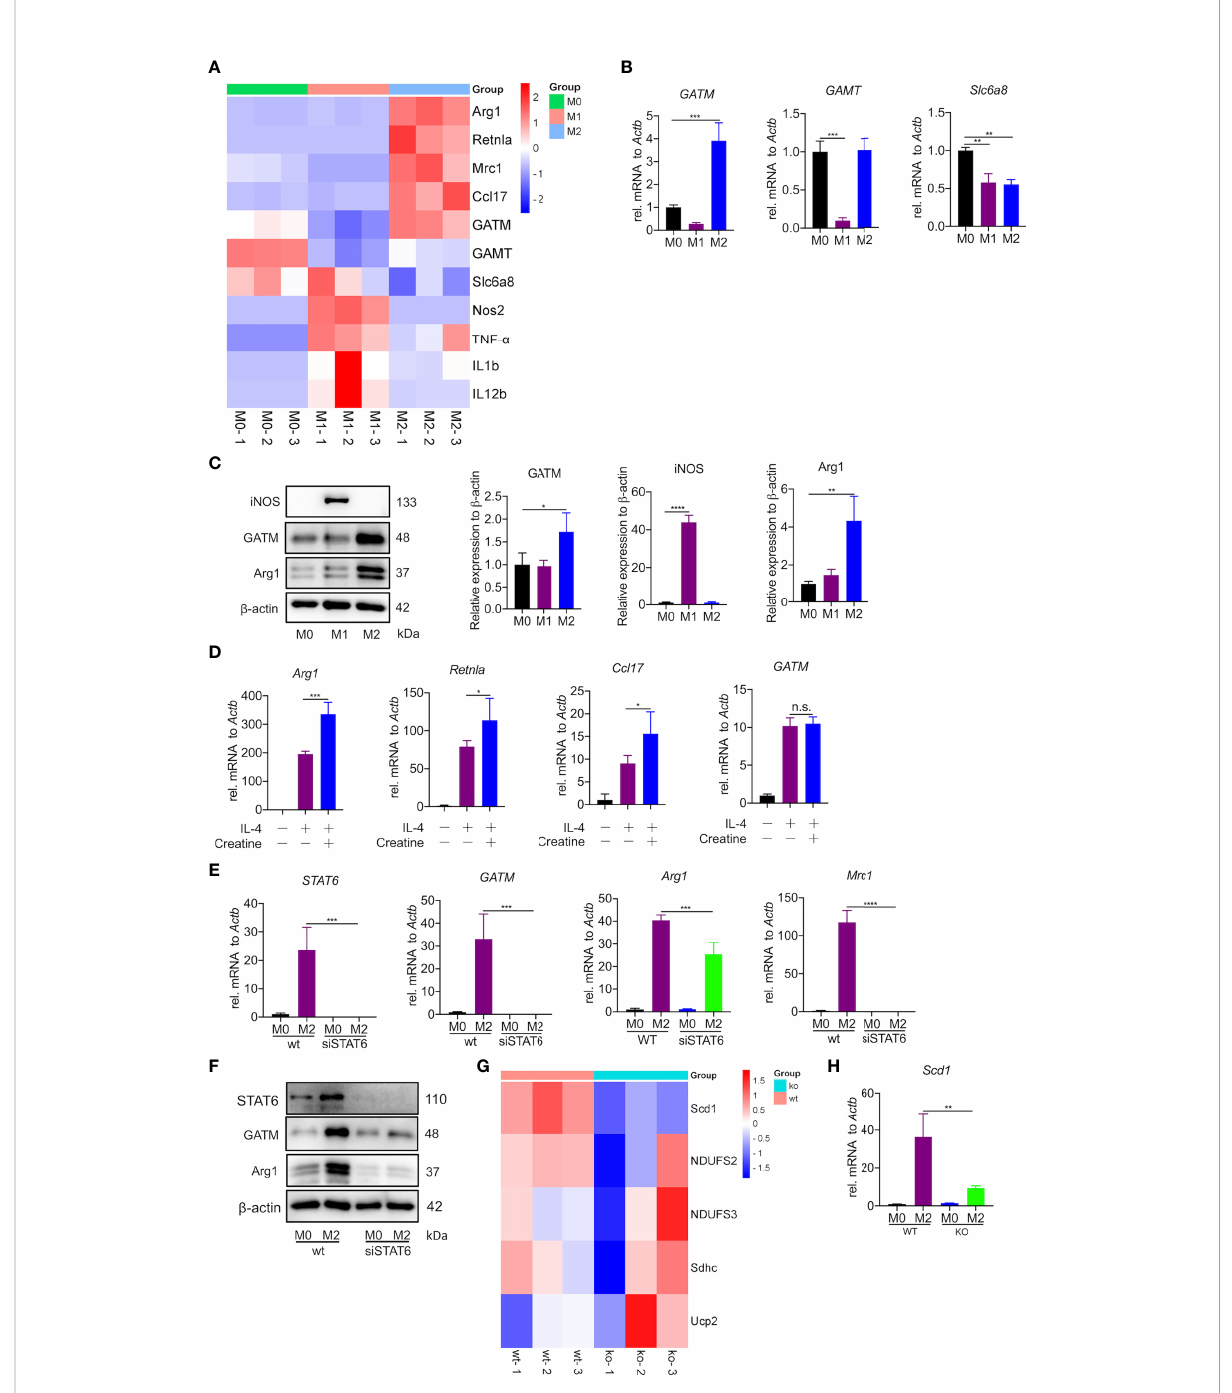
FIGURE 1 Creatine promotes IL-4 induced-M2 polarization in vitro . (A) Heatmap analysis of RNA-seq dataset of PMs showing subsets of genes in M1 and M2 macrophages relative to controls treated with LPS/IFN- g or IL-4 for 24 hours. (B) Transcription levels of GATM, GAMT and Slc6a8 in BMDMs were detected by quantitative PCR (n=3). (C) Arg1 and GATM expression levels in BMDMs were detected using western blotting (n=3). (D) WT BMDMs were pretreated with creatine overnight and subsequently activated with IL-4 for 24 hours. Expression of Arg1, Retnla and Ccl17 mRNA were determined by quantitative PCR (n=4). (E) siRNA blocks STAT6 expression in IL-4 activated (24 hours) AMs. STAT6, GATM, Arg1 and Mrc1 expression was determined by quantitative PCR and (F) , western blotting. (G) Heatmap analysis of RNA-seq dataset of PMs showing subsets of genes in WT and GATM -/- (n=3). (H) Transcription levels of Scd1 in AMs were detected by quantitative PCR (n=3). Data are expressed as mean ± SEM. Statistical signi fi cance was determined by one-way ANOVAs with Tukey ’ s multiple comparisons test; n.s., not signi fi cant * P <0.05, ** P <0.01, *** P <0.001, **** P